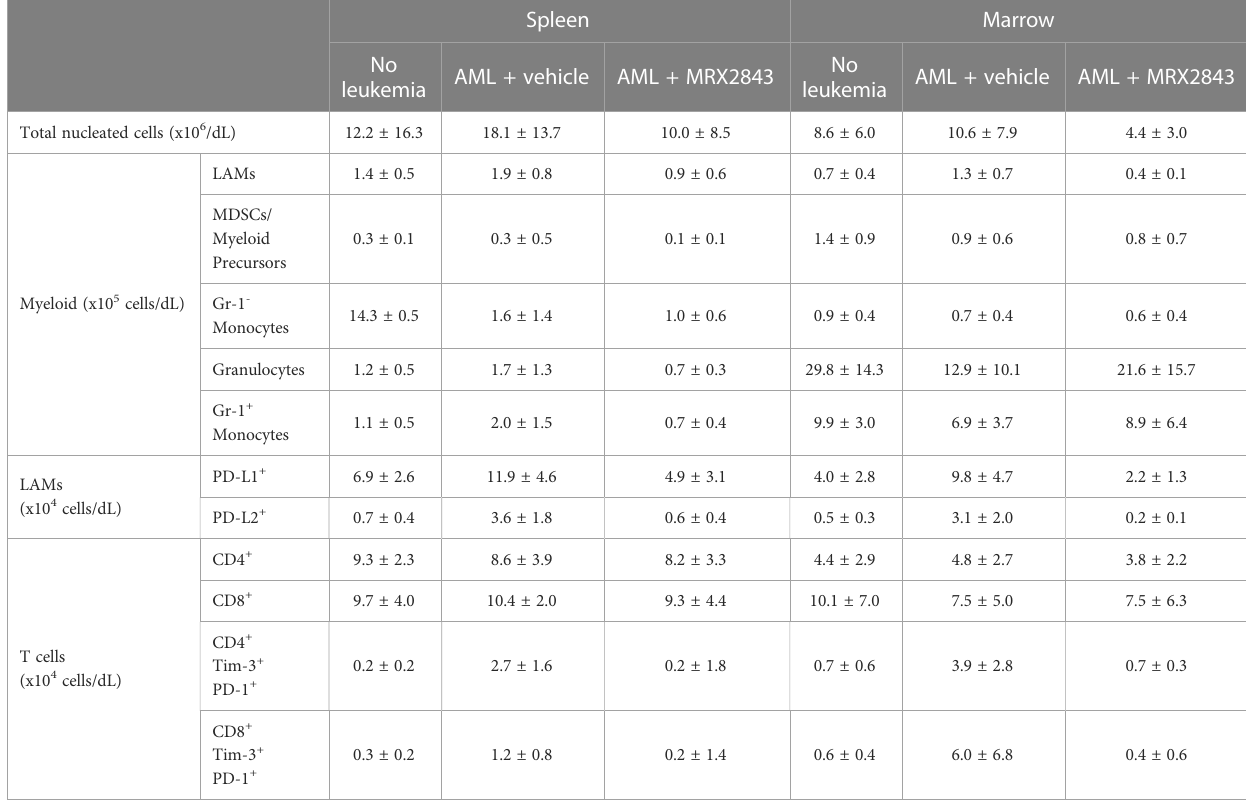
TABLE 1 Cell counts with MerTK inhibition.